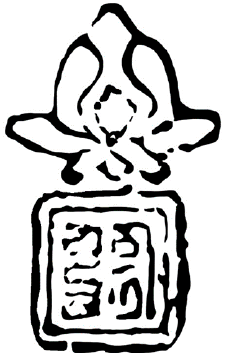
Figure 14. A Song Yuan Huaya with a “Shoutao” lotus and Phagspa characters. The period of the Song and Yuan Dynasties. Sketched by author. Picture source: Shi (1995), p.